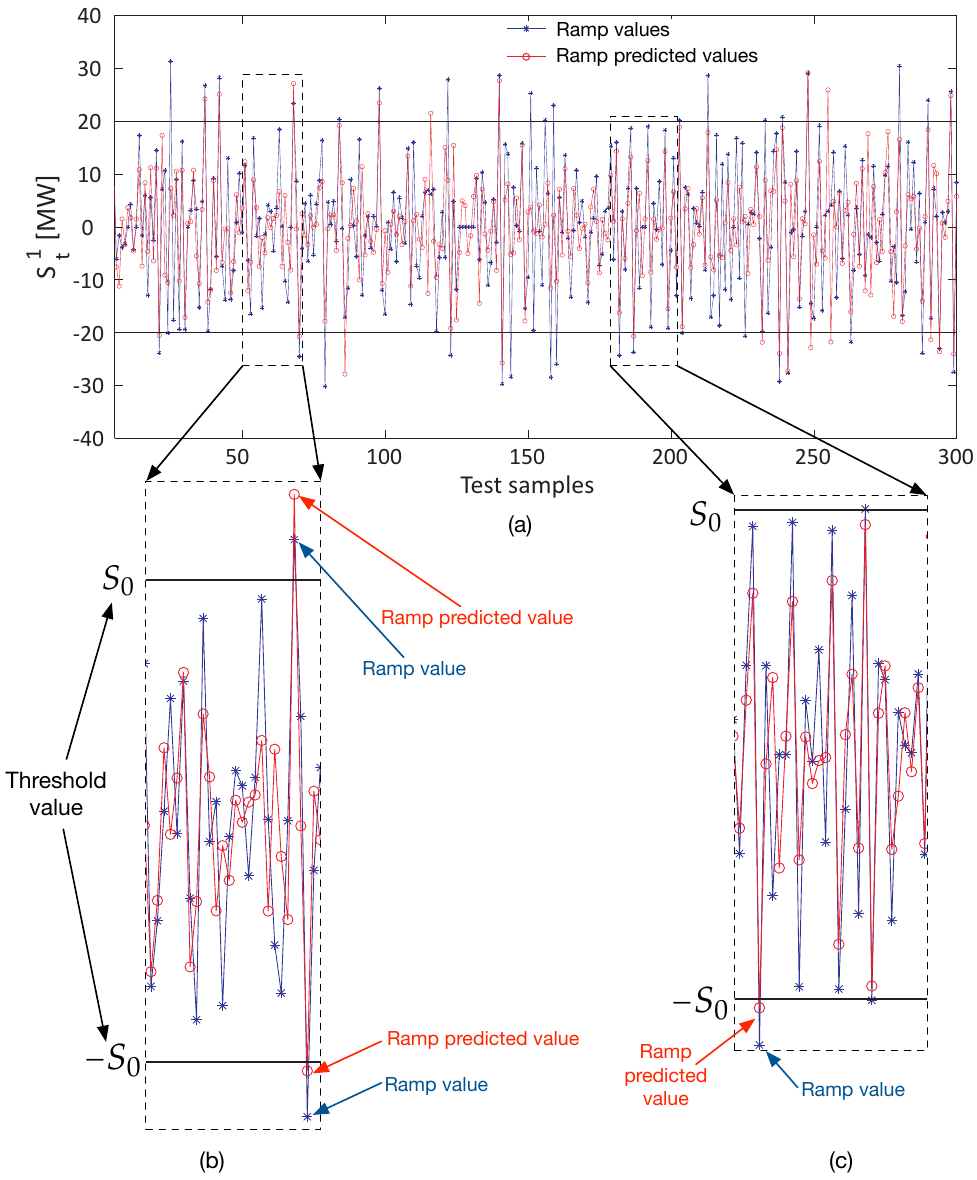
Figure 2. ( a ) Estimation of the ramp function S 1 t ( Equation (1) ) obtained by using the proposed approach in the particular case in which the ML is an ELM regressor. This figure corresponds to Wind Farm A, whose location has been represented in Figure 1. ( b , c ) represent two shorter excerpts in which the predicted WPREs that exceed the thresholds ( S 0 or − S 0 ) are shown to be correctly detected. A WPRE is detected if S 1 t > 0.5 S 0 . The predicted series exhibits RMSE ≈ 5.68 MW, MAE ≈ 4.25 MW, s (+ramp) = 40.54%, s ( − ramp) = 42.59% and s (no ramp) =